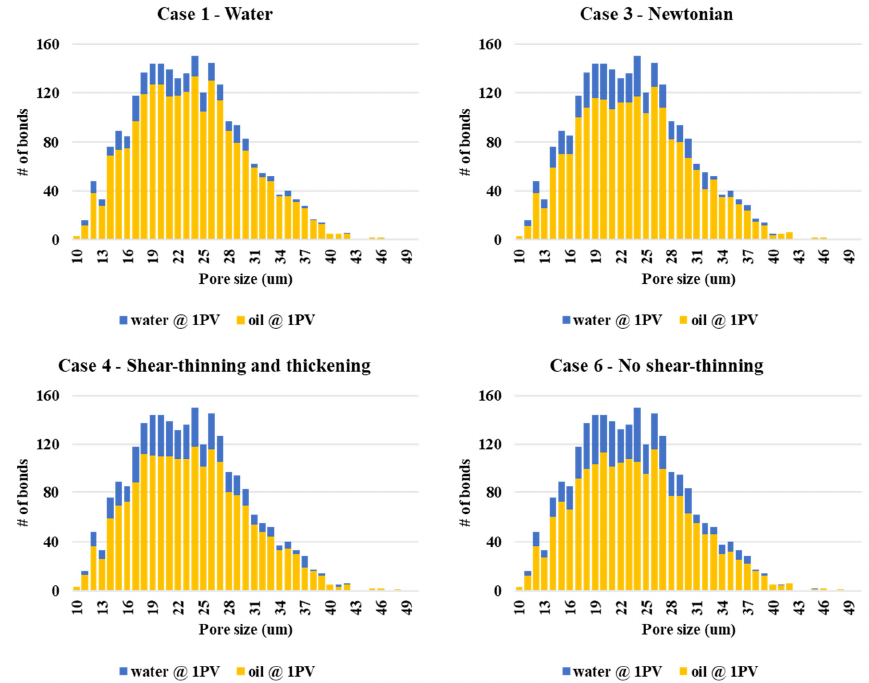
Figure 20. Polymer and water pore (bond) occupancy for the waterflood and the three polymers with an injection rate of 1 × 10 − 13 m 3 /s.